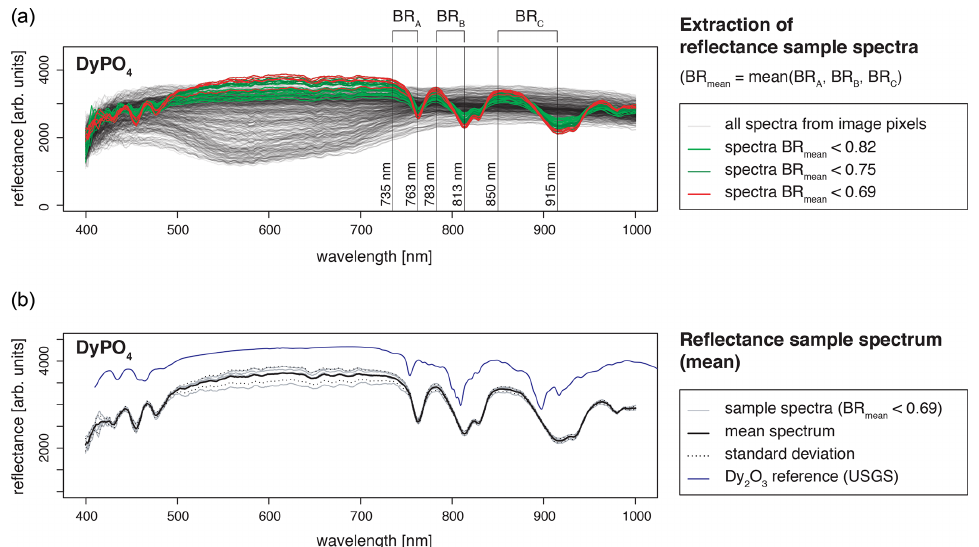
Figure 3. Spatial homogeneity evaluation with hyperspectral reflectance images from a SPECIM FX10 camera with a spatial resolution of 0.17mm (example DyPO 4 ). (a) For REE spectra extraction from all spectra of a measured scene (image), the mean of three band ratios was calculated to reduce influences from noise and ensure accurate identification of sample spectra (pixels containing spectra from the sample grain, in the text referred to as pure sample pixels). Bands were selected according to the position of diagnostic absorption features (BR = band ratio representing the ratio of signal intensities at two given wavelengths). (b) A mean spectrum was calculated from all pure sample pixels. The standard deviation is given as an indication of the variability between spectra of pure sample pixels. The resulting REE absorption spectrum (mean spectrum) was compared to reference data from the USGS spectral library (Kokaly et al., 2017).